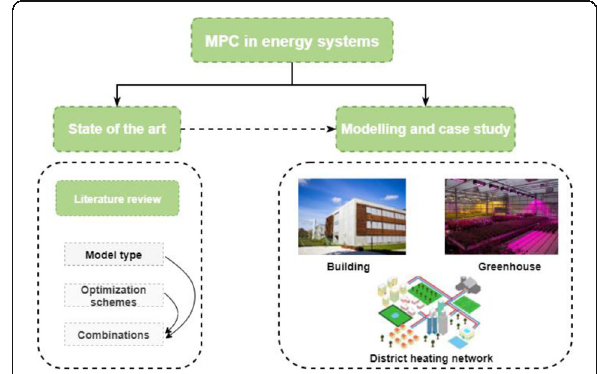
Fig. 3 (Abstract P1). Research workflow of the